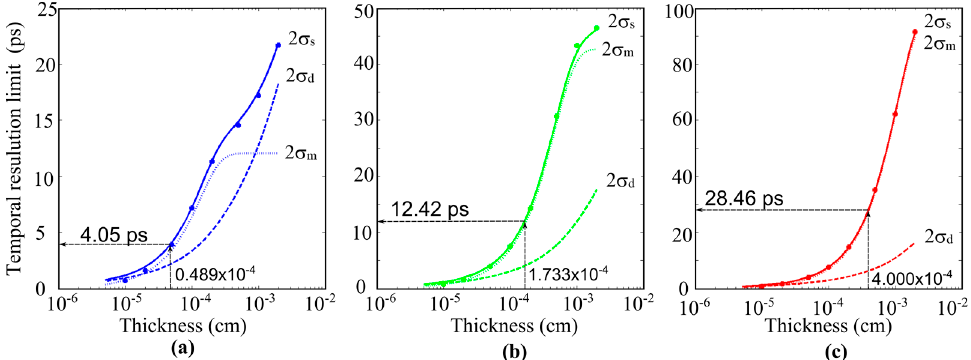
Figure 9. Proof of the derived expression of the temporal resolution limit. (Solid lines: the temporal resolution limit 2 σ s , Equation (9); dotted lines: the mixing effect 2 σ m , Equation (6); dashed lines: the diffusion effect 2 σ d , Equation (7); dots: Monte Carlo simulations.) (Intrinsic silicon <111>; 300 K; electric field: 2.5 × 10 4 V/cm; wavelength: ( a ) 450 nm; ( b ) 550 nm; ( c ) 650 nm.)